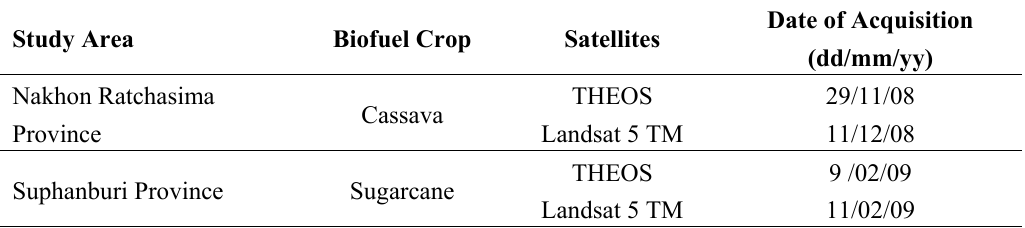
Table 1. Acquisition of THEOS and Landsat 5 TM images for the study